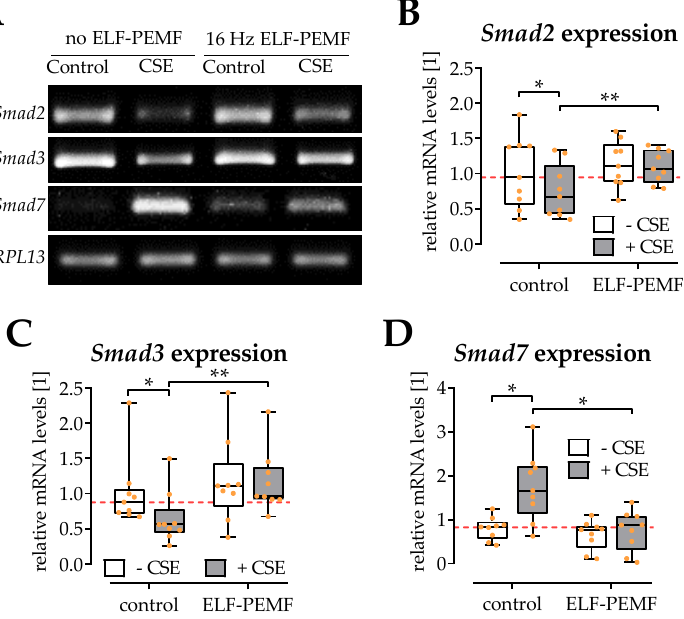
Figure 5. Gene expression of Smads is affected by exposure to 5% cigarette smoke extract (CSE) and 16 Hz ELF-PEMFs for 30 min daily for 3 days. ( A ) Representative RT-PCR images. Signal intensities were quantified with the ImageJ software. Expression of ( B ) Smad2 , ( C ) Smad3 , and ( D ) Smad7 was normalized to RPL13 (house-keeping gene). N = 3, n = 3. Data are presented as box plots (Min to Max with single data points). Data were compared by non-parametric two-way ANOVA followed by Tukey’s multiple comparison test: * p < 0.05 and ** p < 0.01 as indicated.